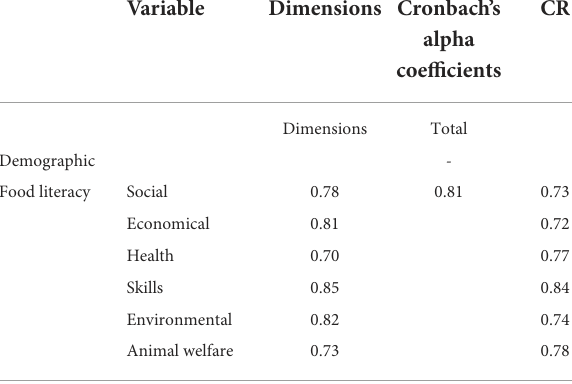
TABLE 2 Cronbach’s alpha and CR coefficients of the questionnaire variables.